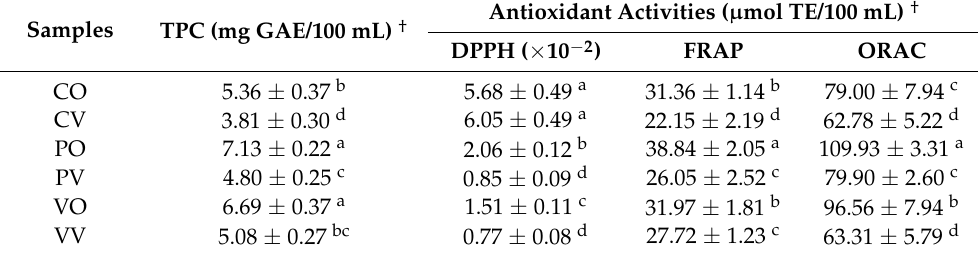
Table 3. Antioxidant properties of date syrups prepared using different extraction and evapora- tion